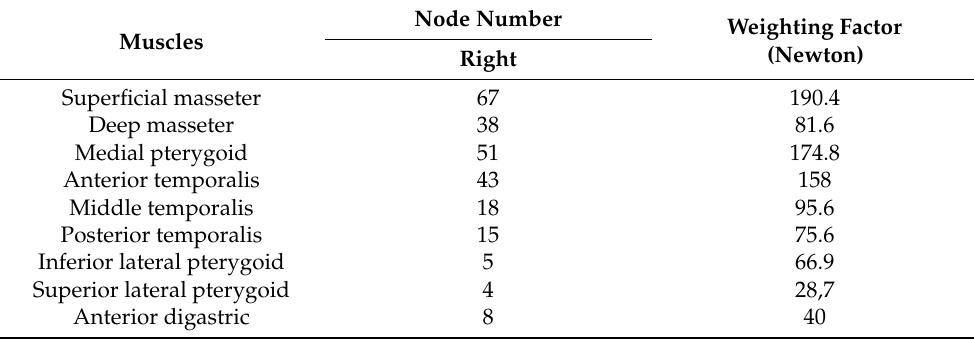
Figure 2. Spherical solid material simulating foodstuff located on the left first molar region. Table 3. Node number and weighting factor allocated to the masticatory muscles responsible for the five clenching tasks.